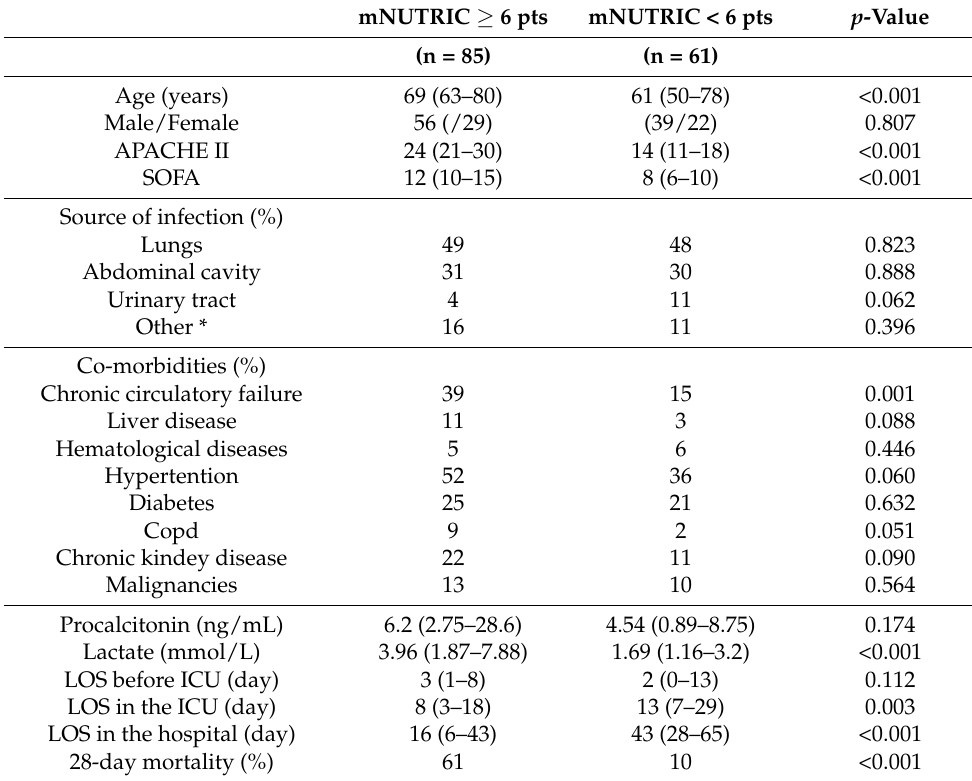
Table 2. Baseline patient characteristics according to the NUTRIC